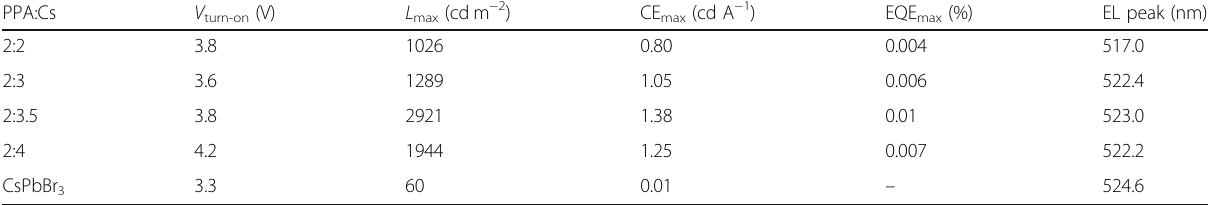
Table 2 Summary of detailed PeLED performance